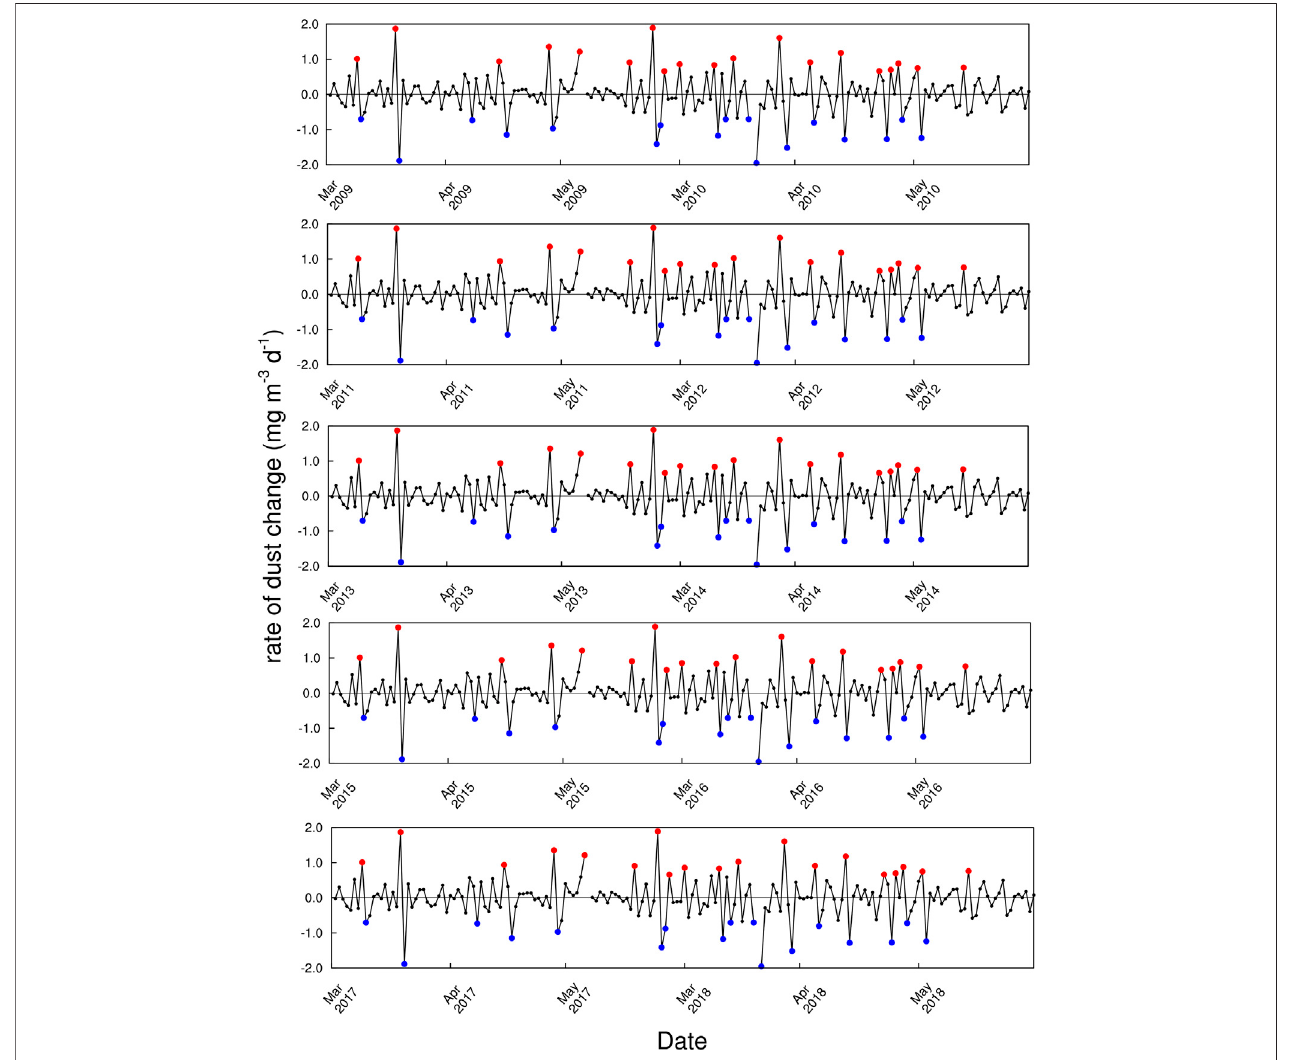
FIGURE 8 | Time variation of dust concentration (units: mg m − 3 d − 1 ) over the TP in spring for 2009 – 2018 and selected cases representing atmospheric dust (red dots) and dust-on-snow (blue dots).